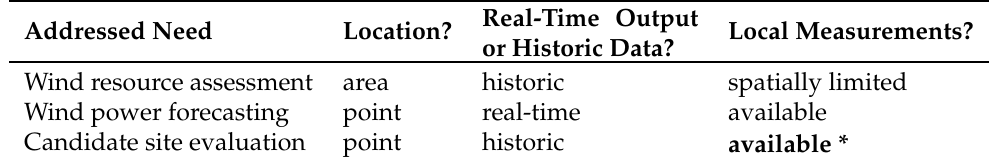
Table 1. Requirements for fulfilling different needs in wind power. Wind resource assessment characterizes the resource over an area, is performed on historical data, and has long-term time series data available at most for a limited set of locations in the area. Wind power forecasting addresses a selected site, has to work in real time, and it has real-time measurements from the site available. Evaluating a candidate site is done for a selected site on historical data. Traditionally, it requires long-term time series measurement data from the site, while the proposed method performs it with a shorter-term time series of measurements from the site, supported with other available